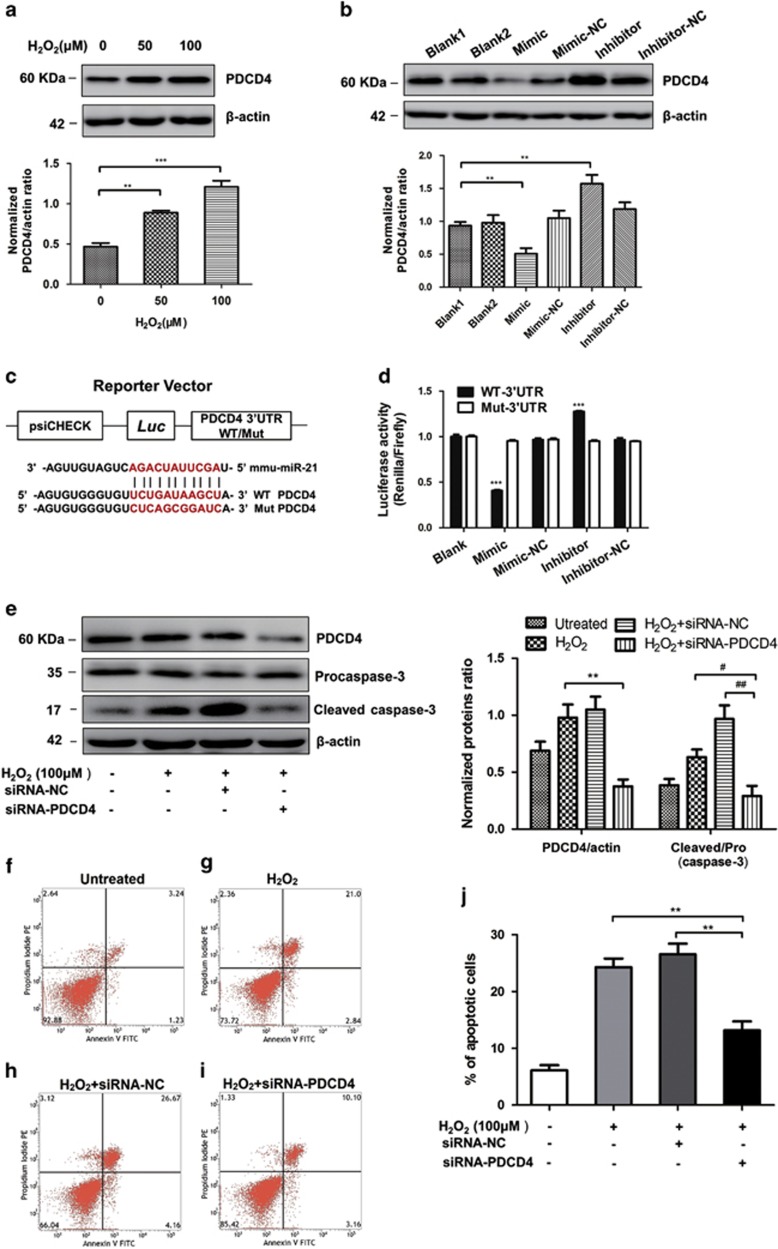
PDCD4 is a target gene of miR-21. (a) Western blotting analyzed PDCD4 in H9C2 cells after different concentrations of H2O2 treated (N=4, **P<0.01, ***P<0.001 versus 0 μM). (b) One hundred micromolar H2O2-treated H9C2 cells transfected with miR-21 mimics, inhibitors and both negative controls, western blotting analyzed PDCD4 protein levels in H9C2 cells (N=3, *P<0.05, **P<0.01, ***P<0.001 versus blank group). (c) Schematic representation of 3′-UTR of PDCD4 mRNA reporter with and without the miR-21 seed-binding site (red). (d) Luciferase activity assay of HEK293T cells transfected with luciferase constructs containing WT-3′UTR and Mut-3′UTR of PDCD4 (N=3, ***P<0.001 versus blank group). (e) Western blot analyzed the protein levels of caspase-3 and PDCD4 after H9C2 transfected with siRNA-PDCD4 (N=3, **P<0.01 versus H2O2 group, #P<0.05, ##P<0.01 versus siRNA-PDCD4 group). (f–h) Representative dot plots of cell apoptosis were showed after Annexin V/PI dual staining. The proportion of dead cells (Annexin V−/PI+), live cells (Annexin V−/PI−), early apoptotic cells (Annexin V+/PI−) and late apoptotic/necrotic cells (Annexin V+/PI+) was respectively measured for comparison. (j)The percentage of apoptotic cells was represent for both early and late apoptotic cells (N=3, **P<0.01 versus siRNA-PDCD4 group)